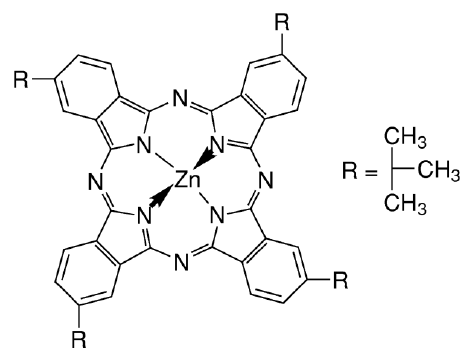
Figure 1. Molecular structure of ZnTTBPc thin